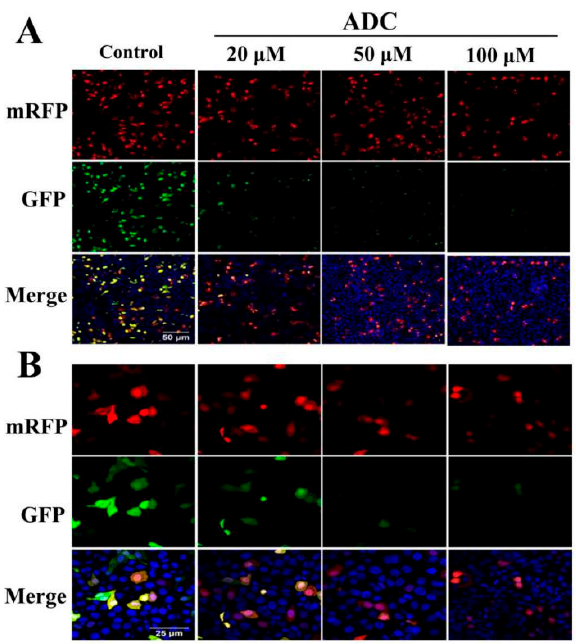
Figure 10. ADC induced autophagy flux. The living cell image was found using a laser scanning confocal microscope. The images were then magnified 30 times ( A ) and then 60 times ( B ).